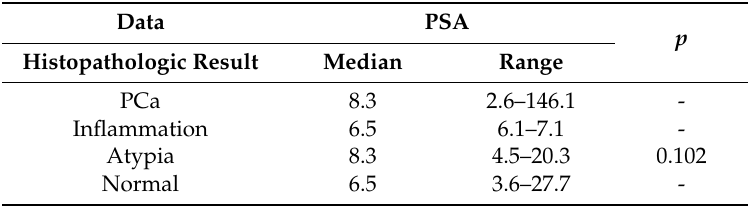
Table 2. Median serum PSA levels in relation to histopathologic results—group A + B. Values are presented as medians/ranges.